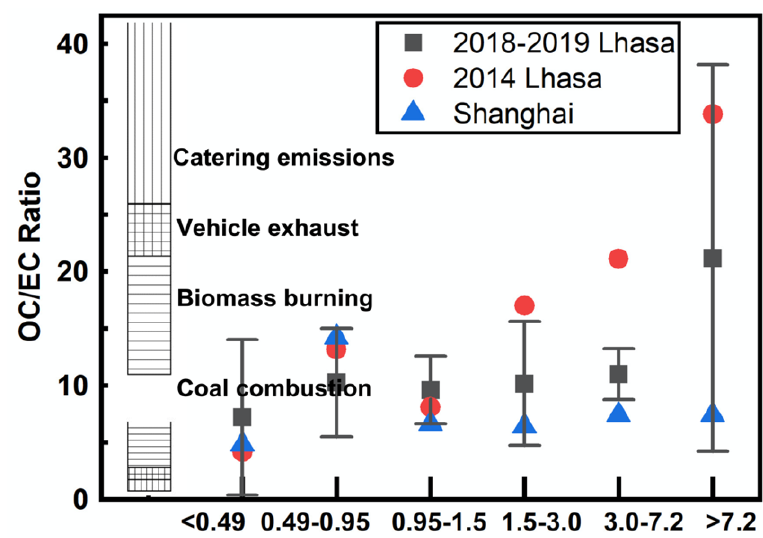
Figure 4. Comparison of OC − EC ratios of different particle sizes between Lhasa and Shanghai.